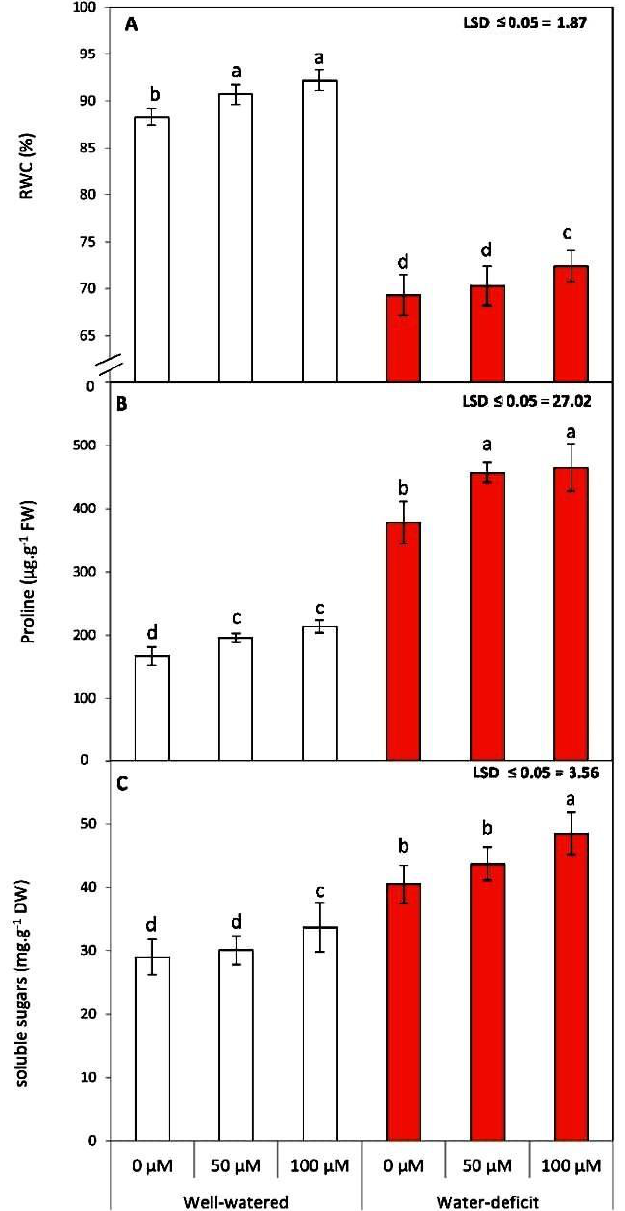
Figure 3. Effect of SNP as foliar applications at 0, 50, and 100 µ M on leaf’s relative water content (RWC) ( A ), proline ( B ), and soluble sugars ( C ) of tomato plants grown under well-watered and water deficit irrigation. Data followed by the same letters are not significantly different using the LSD multiple rang test at a 5% level.